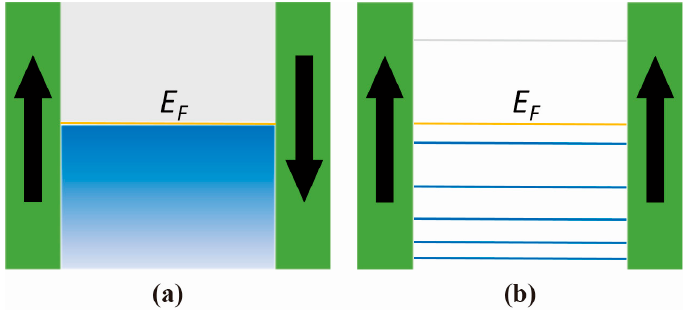
Figure 2. Electron distribution schema of the ( a ) AFM coupling and ( b ) FM coupling state. At the ground state, electrons occupy only those states below the Fermi level ( E F ) (occupied states are colored blue, unoccupied colored gray).